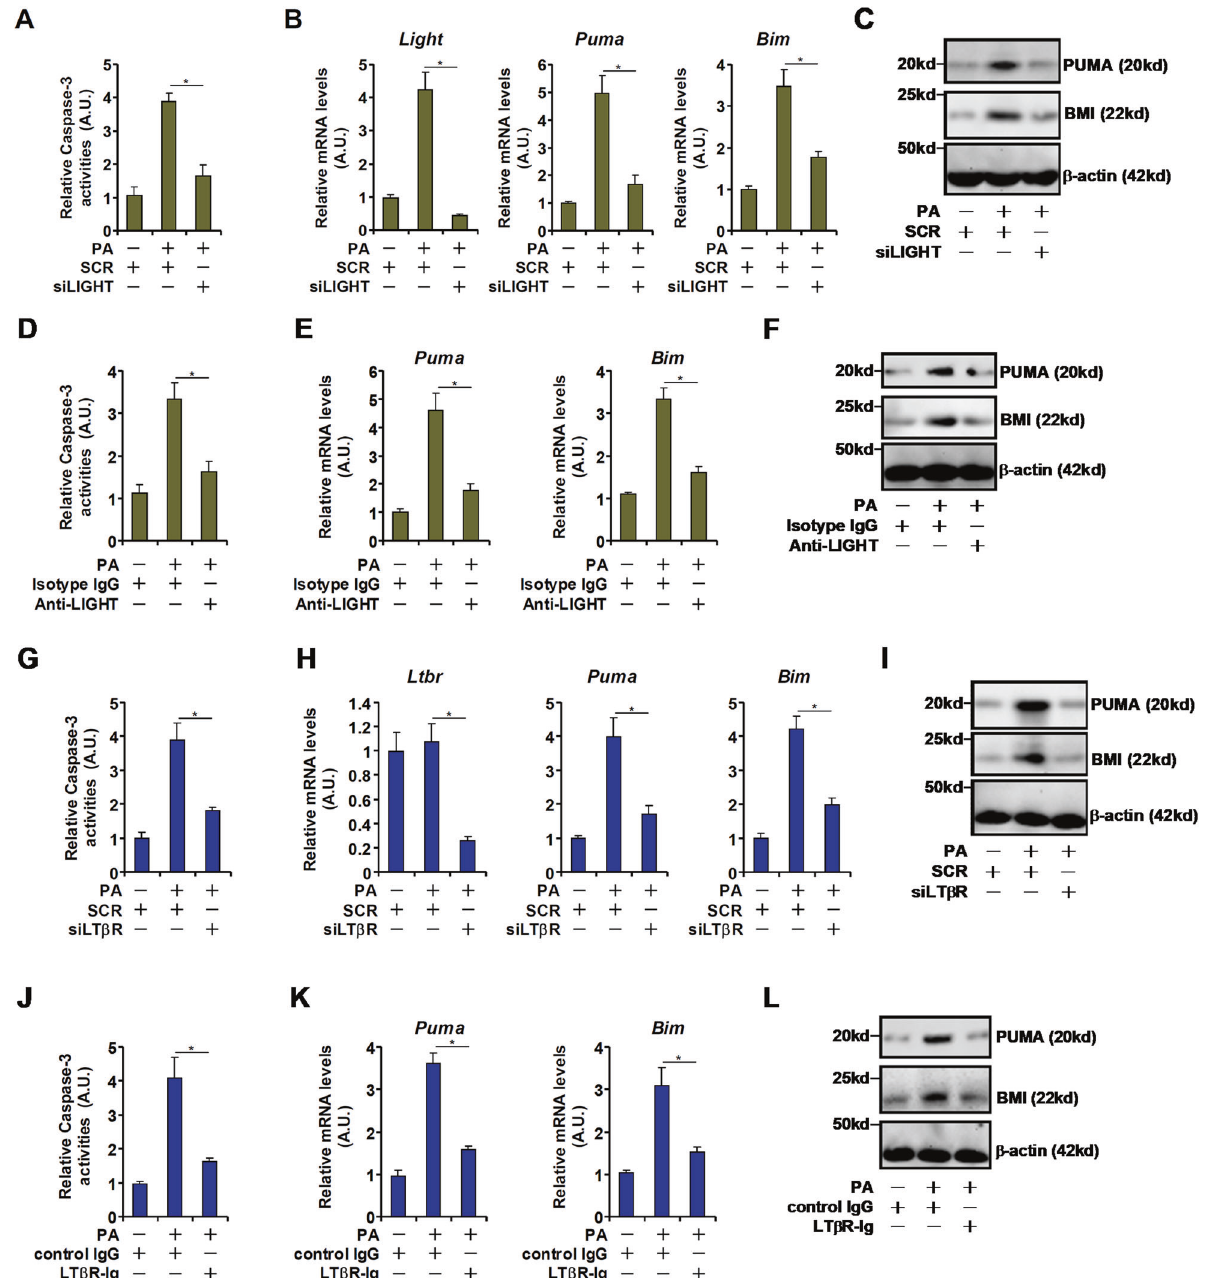
Fig. 2 LIGHT blockade attenuates PA-induced hepatocyte apoptosis. A – C Primary murine hepatocytes were transfected with siRNA- targeting LIGHT or scrambled siRNA (SCR) followed by treatment with PA (0.3 mM). Caspase-3 activity was measured by a fl uorescence kit as described in Methods. Gene expression was evaluated by qPCR and western blotting. D – F Primary hepatocytes were treated with PA (0.3 mM) in the presence or absence of a LIGHT neutralizing antibody. Caspase-3 activity was measured by a fl uorescence kit as described in Methods. Gene expression was evaluated by qPCR and western blotting. G – I Primary murine hepatocytes were transfected with siRNA-targeting LT β R or scrambled siRNA (SCR) followed by treatment with PA (0.3 mM). Caspase-3 activity was measured by a fl uorescence kit as described in Methods. Gene expression was evaluated by qPCR and western blotting. J – L Primary hepatocytes were treated with PA (0.3 mM) in the presence or absence of a LIGHT neutralizing antibody. Caspase-3 activity was measured by a fl uorescence kit as described in Methods. Gene expression was evaluated by qPCR and western